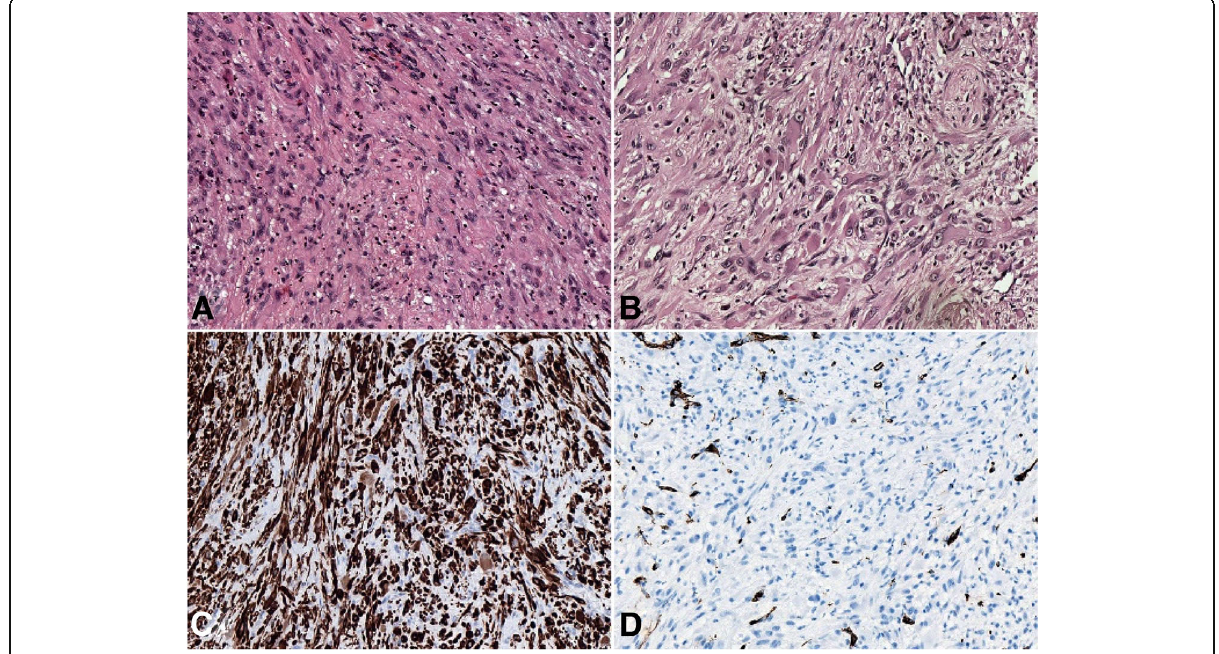
Fig. 1 Microphotograph of tumor tissue by FANB. a . Loose fascicles of bland spindle cells with neutrophils scattered in the stroma (H&E, 200x). b . Rhabdomyoblast-like appearance of tumor cells with brightly eosinophilic cytoplasm (H&E, 200x). c . Strong extensive expression of AE1/AE3 in the neoplastic cells (200x). D.CD 34 were negative in tumor cells